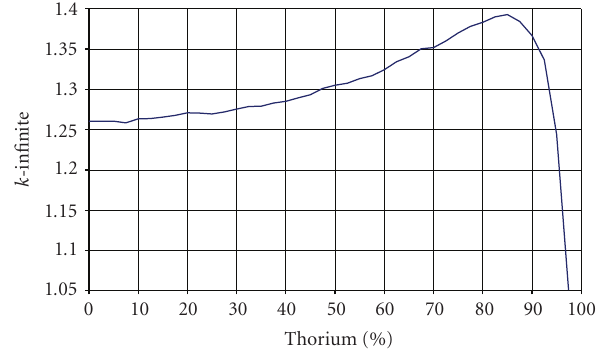
Figure 9: Variation of k -infinite at BOC as a function of Th content.